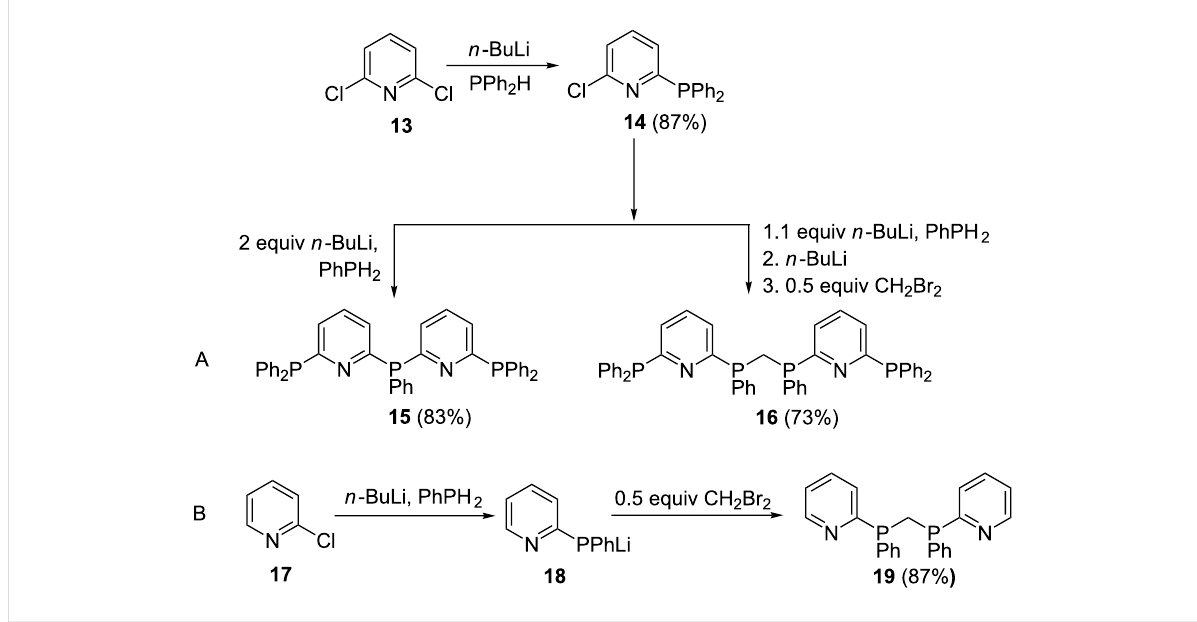
Scheme 3: Synthesis of linear multi-chelate pyridylphosphine ligands.